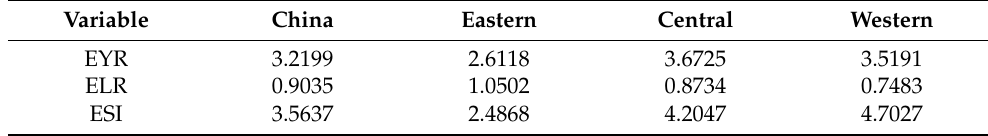
Table 5. Regional comparison results on agricultural sustainability in China,